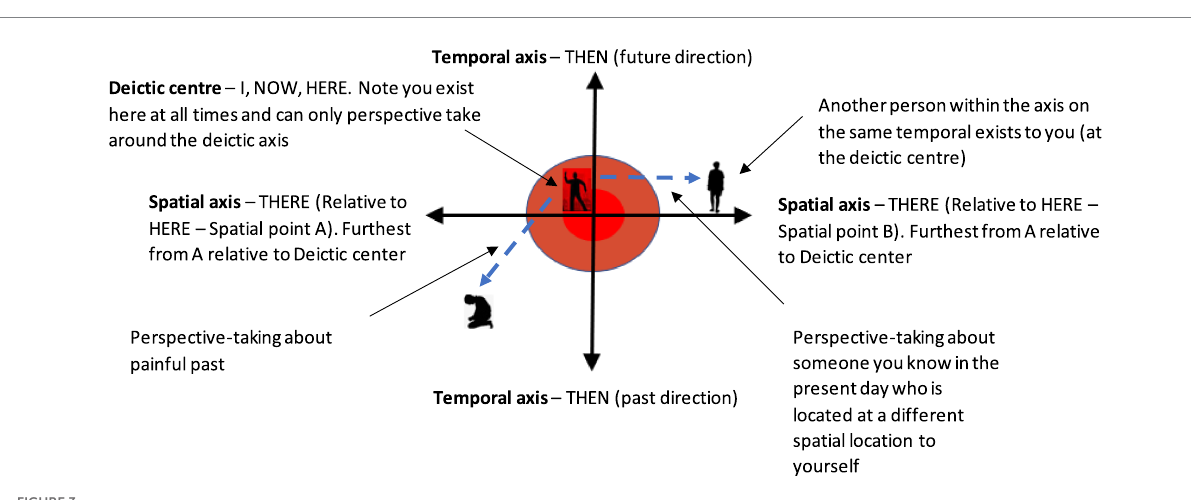
FIGURE 3 The deictic axis—a visual representation of an individual who relationally frames themselves in the present moment while mindfully observing their painful past. This would be expressed as “I” in the “HERE” and “NOW” as “I” perspective-take about my painful past in the “THERE” and “THEN.”